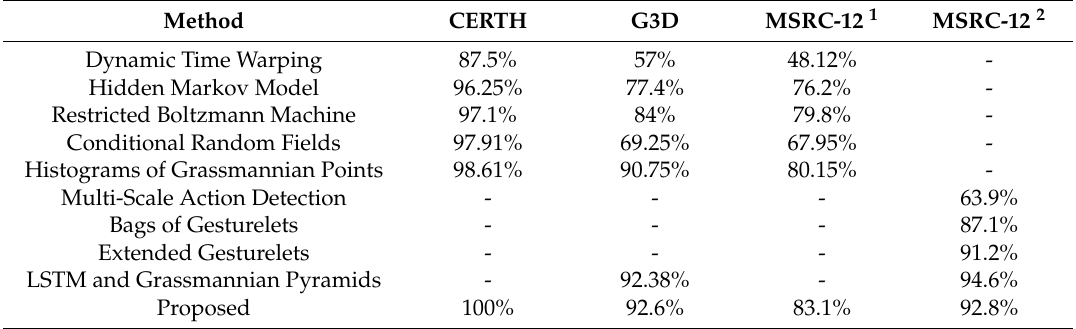
Table 2. Experimental comparison results for CERTH, G3D, and MSRC-12